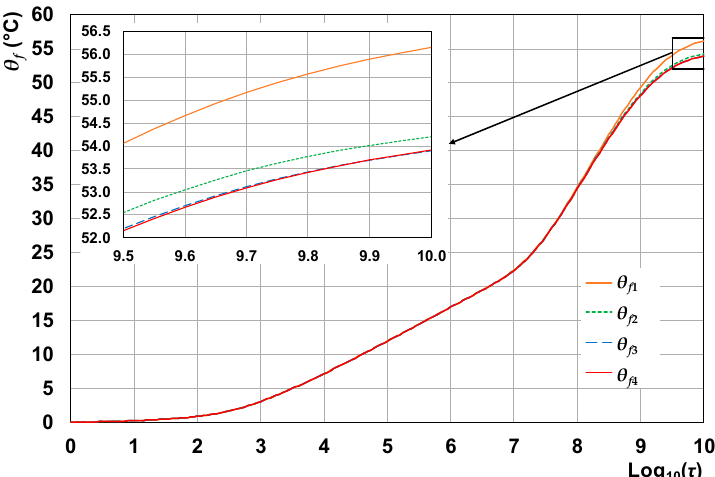
Figure 7. Fluid-to-ground thermal responses of the 2 × 2 borefield versus log 10 ( τ ), with the isoflux condition ( θ f 1 ) and with the isothermal conditions ( θ f 2 , θ f 3 , θ f 4 ), OMEC model.